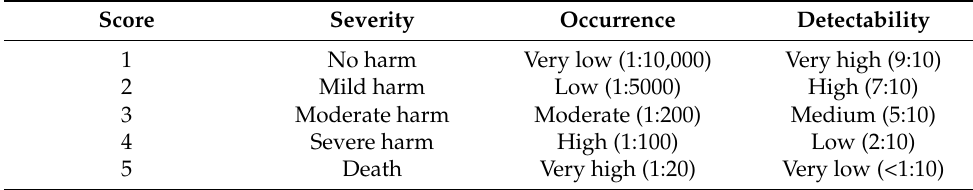
Table 1. RPN variables, labeling, and relations to their scores.